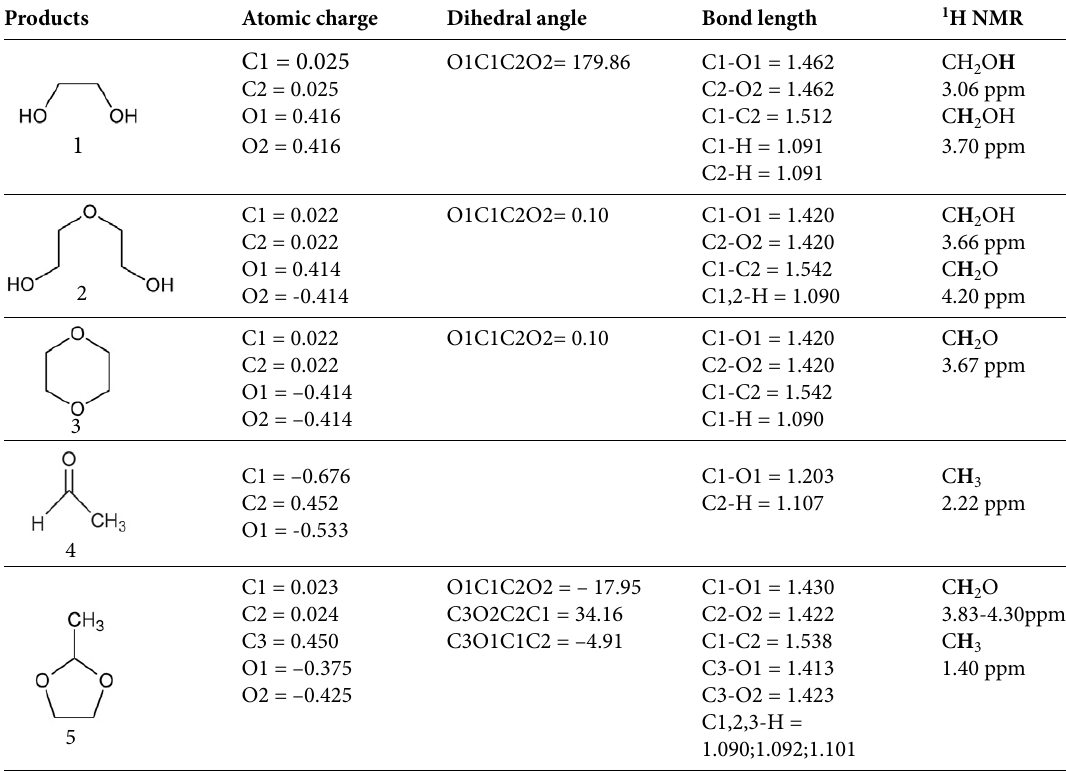
Table 3. Some physical characteristics of ethylene glycol ( 1 ) and its derivatives 2 – 5